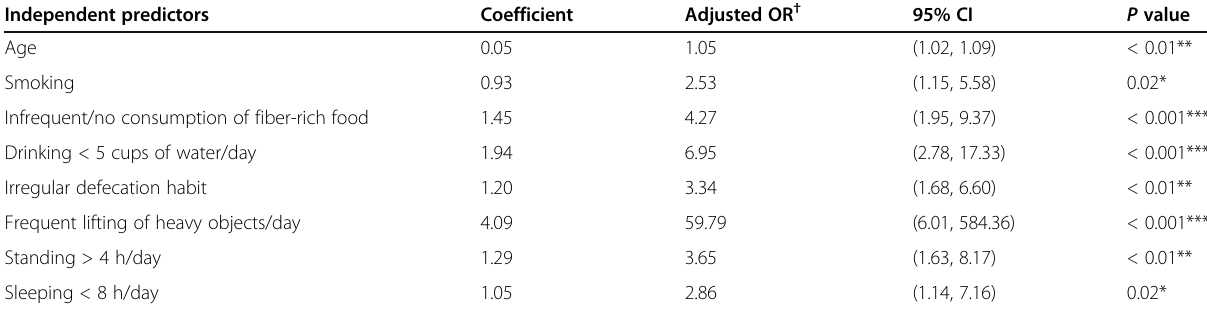
Table 4 Stepwise logistic regression analysis of the independent predictors of lower limb varicose veins (LLVV) among all participants ( n =